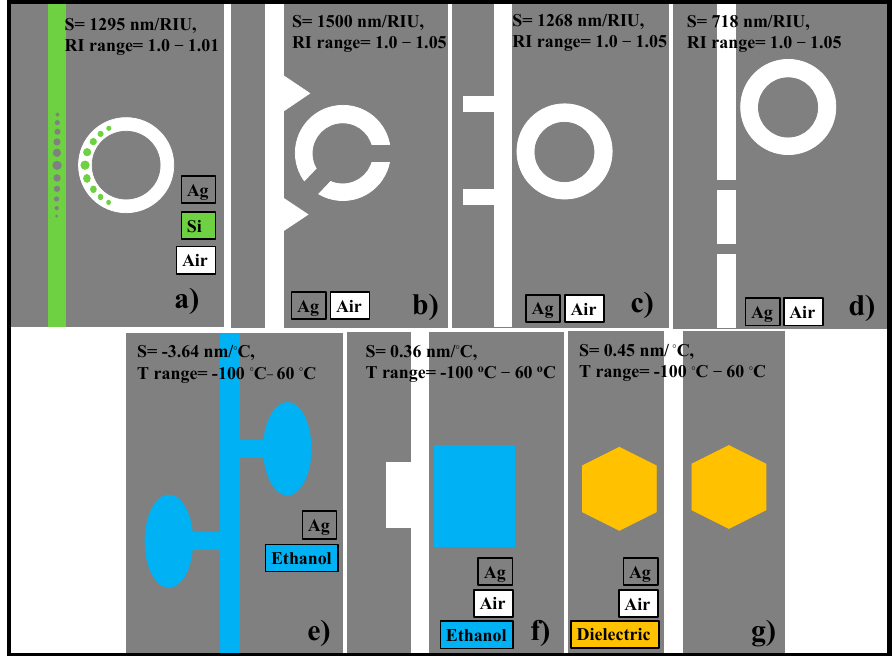
Figure 1. Schematic representation (top view) of single-purpose plasmonic sensor designs found in the literature. Refractive index sensor, ( a ) ring resonator coupled to an MIM waveguide containing tapered defects [24], ( b ) two triangle stubs coupled with a split-ring nanocavity [25], ( c ) two stubs and one ring resonator [26], and ( d ) two baffles and a coupled ring cavity [27]. Temperature sensors, ( e ) ethanol-sealed asymmetric ellipse resonators [9], ( f ) ethanol filled resonator cavity [23], and ( g ) dual laterally side-coupled hexagonal cavities